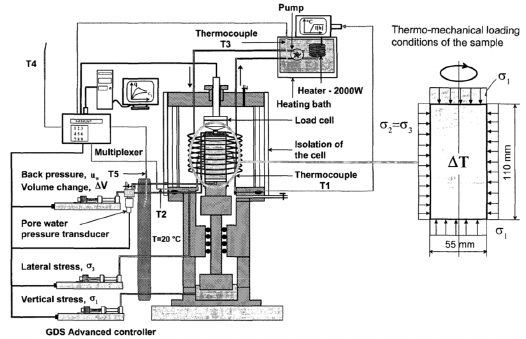
Figure 23. Triaxial device with controlled temperature [203].